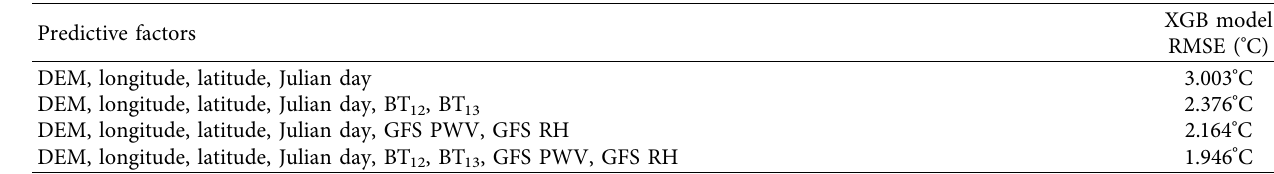
Figure 10: Time series (June to August 1st, 10th, 20th, and 30th) of RMSE of estimated T Table 3: The contribution of AGRI BTs and GFS data to the XGB T Predictive factors